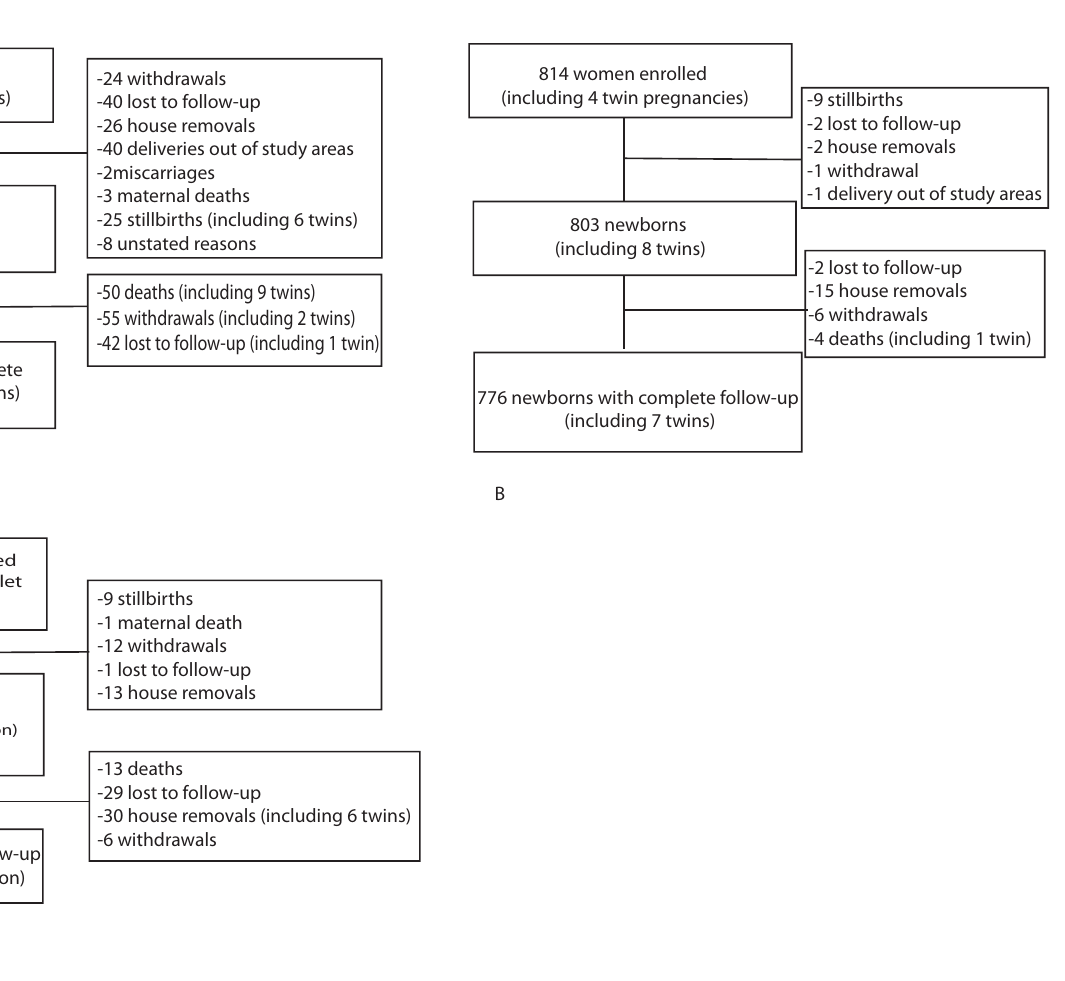
Fig 1. Flowchart of the study population. (A) Madagascar, (B) Cambodia, and (C) Senegal.